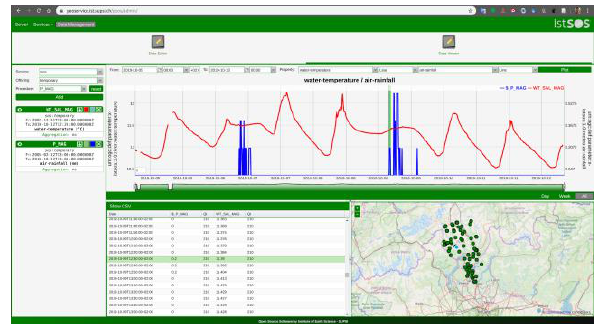
Figure 3. istSOS administration Web interface adopted to enable sensor data interoperability in the SIMILE Project.